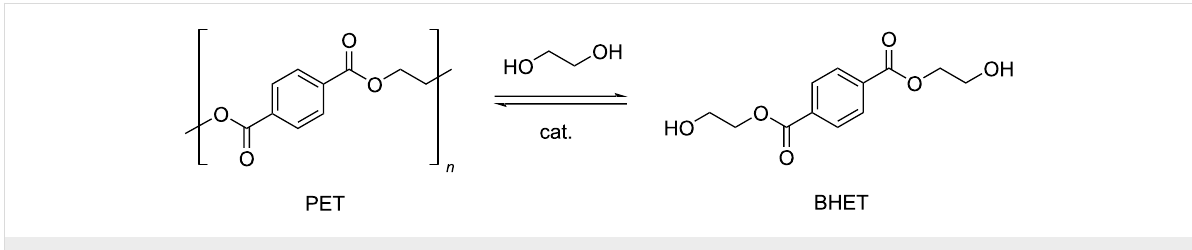
Scheme 5: Depolymerisation of PET by glycolysis with ethylene glycol.